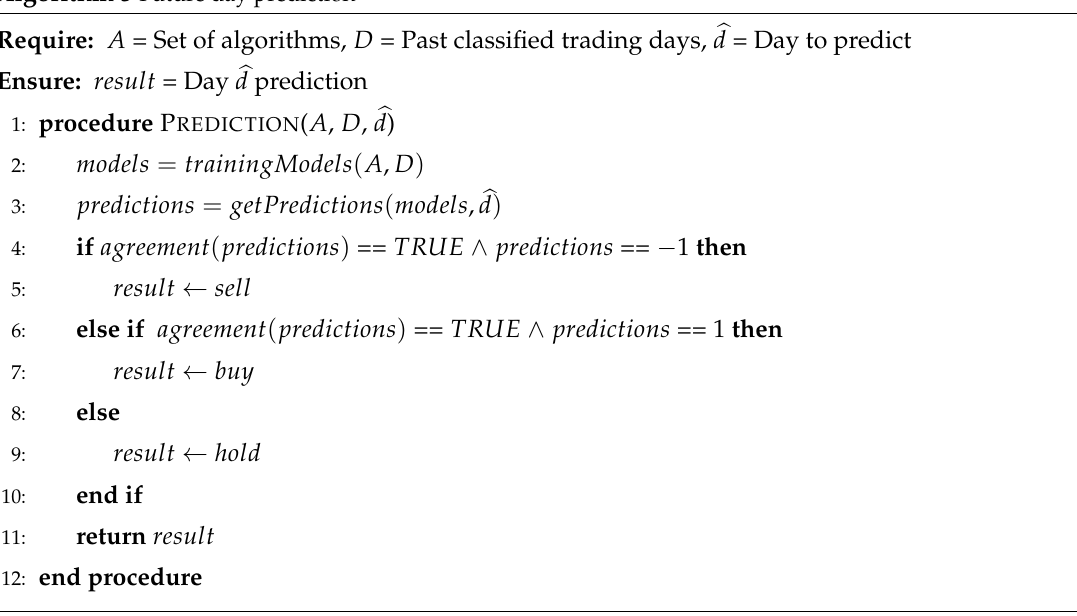
Algorithm 3 Future day prediction